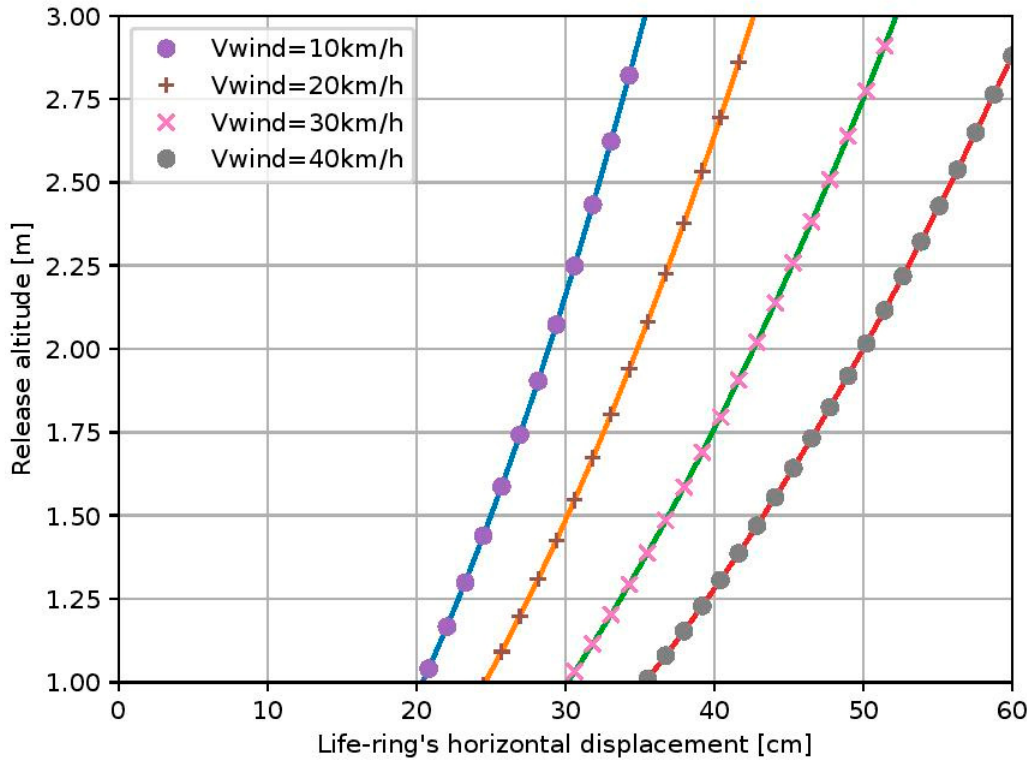
Figure 9. The life-ring’s horizontal displacement related to the UAV’s release altitude under several wind speeds.